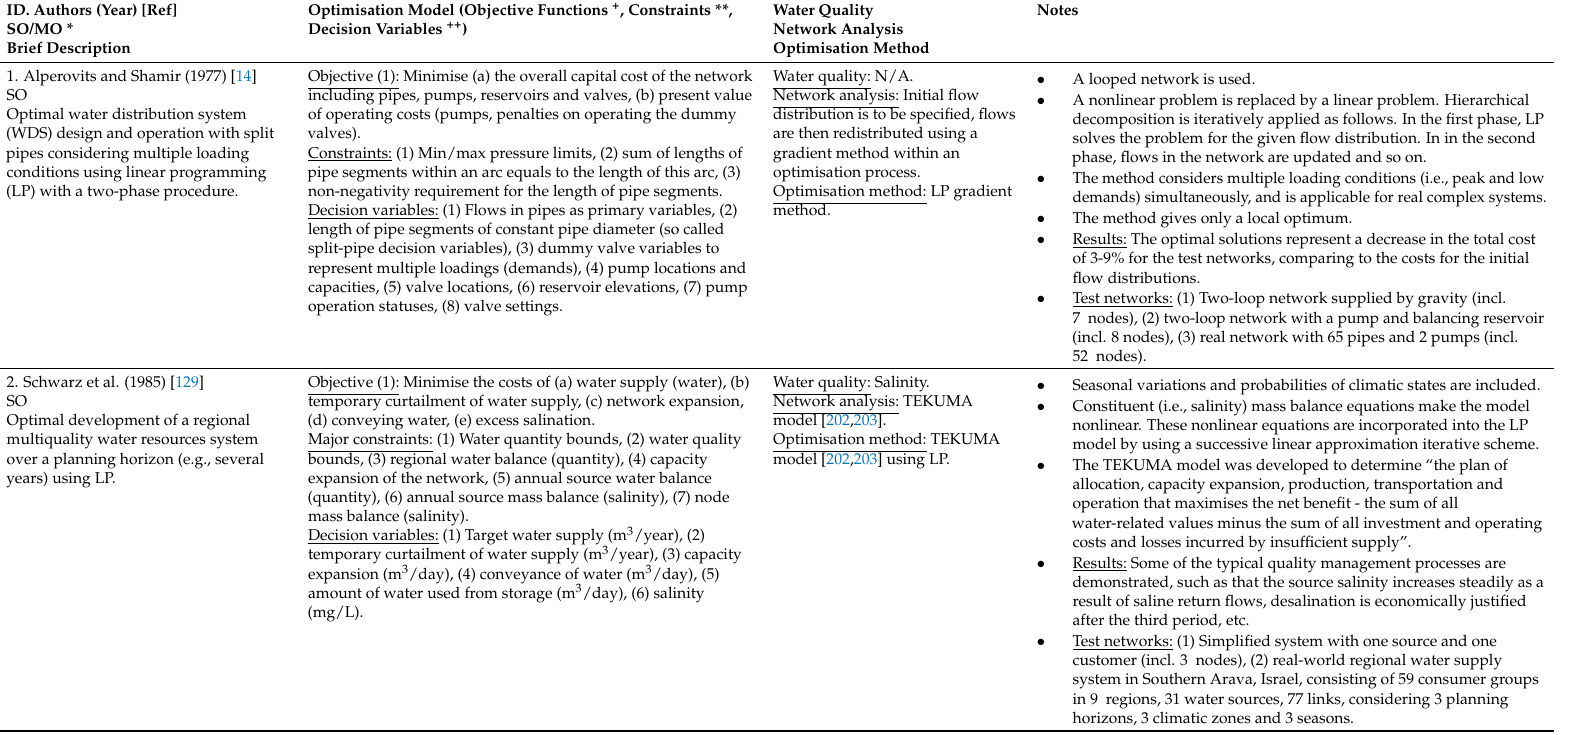
Table A1. Papers reviewed in a chronological